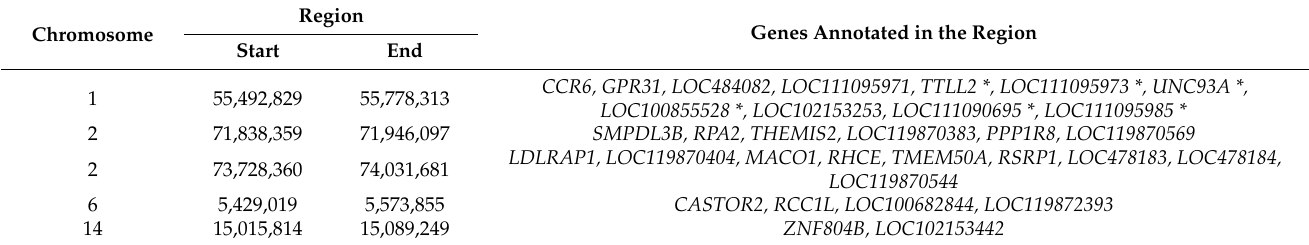
Table 1. List of detected ROH islands with 100% incidence and their gene content. Region